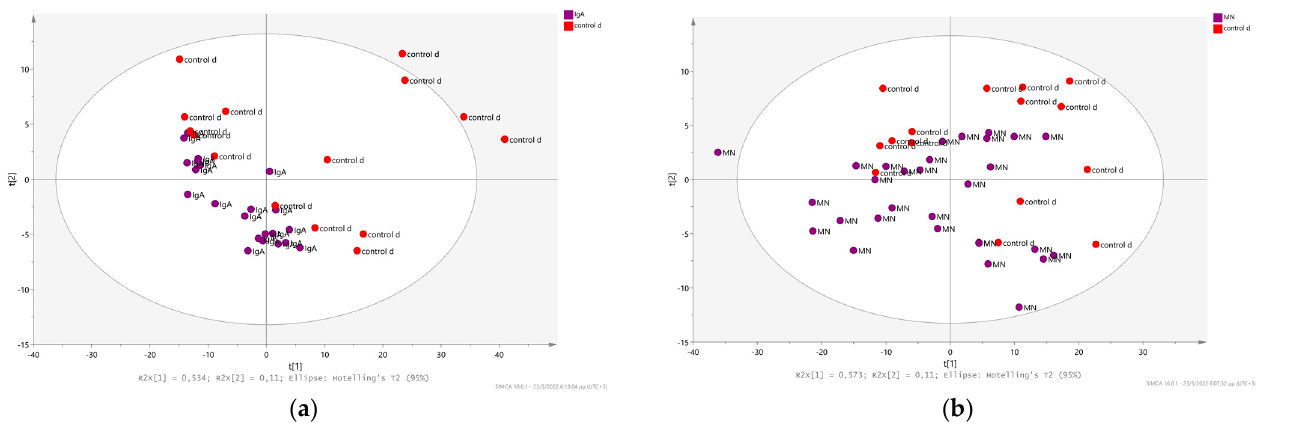
Figure 3. Urinary metabolic fingerprint comparison of Glomerulonephritis subtypes and control disease patients. Schemes follow another format. If there are multiple panels, they should be listed as: ( a ) PLS-DA 2D scores plot of 1 H CPMG data matrix showing the separation between the urine fingerprint of IgAN (purple spheres) and control disease (orange spheres); ( b ) PLS-DA 2D scores plot of 1 H CPMG data matrix showing the separation between the urine fingerprint of MN (purple spheres) and control disease (orange spheres).